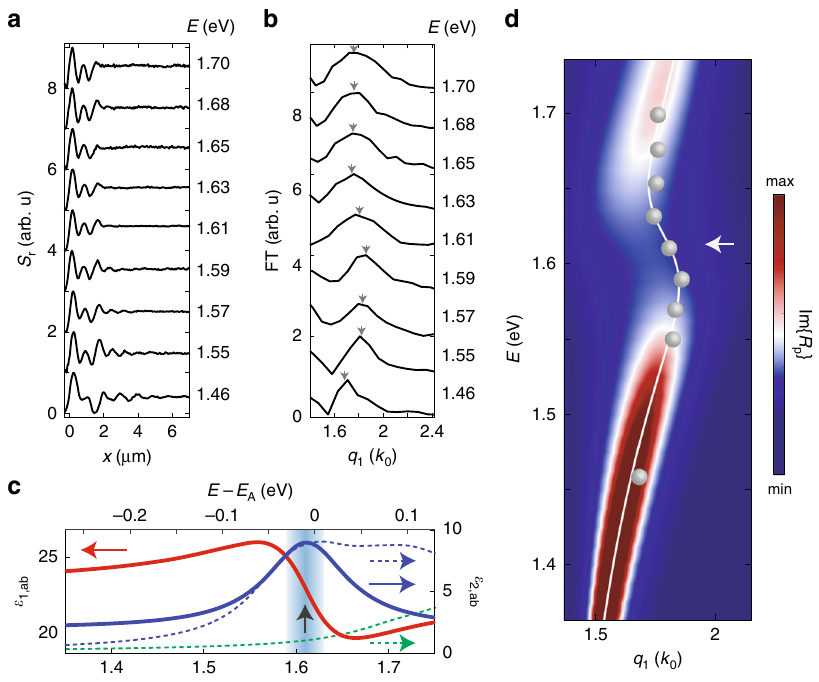
Fig. 2 Steady-state electrodynamics of the WSe 2 crystal from spatio-temporal nano-imaging. a Near- fi eld scattering amplitude, S r , at several probe energies (1.46 – 1.70 eV) plotted as a function of the real space coordinate relative to the edge of the 90 nm thick WSe 2 crystal. b Fourier transforms of the data in panel a are shown in units of k 0 , the wavevector of light in free space, after angular correction (see Supplementary Note 2). The arrows indicate the real part of the dominant wavevector, q 1,r (see Supplementary Notes 2 – 4). The data presented in panels a and b are offset for clarity. c The in-plane component of the dielectric function of bulk WSe 2 ( ε 1,ab shown in red, ε 2,ab shown in blue) obtained from a series of Lorentzian oscillators with parameters reported in Supplementary Table 1 (see Supplementary Note 8). The imaginary component of the dielectric function obtained from fi rst principles calculations including excitonic effects (dashed blue curve) can be compared with the result obtained when excitonic effects are excluded (dashed green curve). The energy scale for the theoretical calculations is on the top, which was offset by the A-exciton energy (see Supplementary Note 8). The A- exciton energy, E x , is indicated with a black arrow. d The energy versus momentum dispersion of the waveguide mode calculated with the in-plane component of the dielectric function represented by the Lorentz model (shown in panel c ). The dispersion is represented with the imaginary component of the p-polarized re fl ection coef fi cient, Im{R p } (false color map) along with the analytical solution (white line; Supplementary Notes 3, 4). The experimental results for q 1,r vs. E extracted from the data of panels a and b are displayed with gray dots. The energy E x is indicated with a white